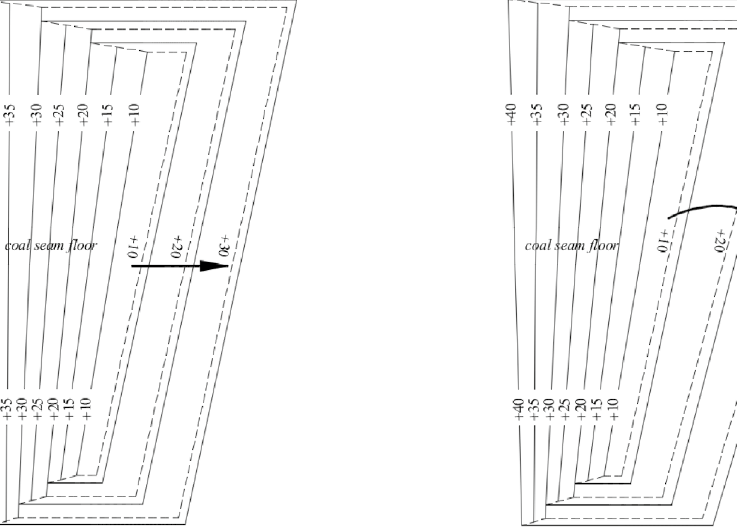
Fig. 6 Layout and develop- ment mode of oblique working line in steeper anticline